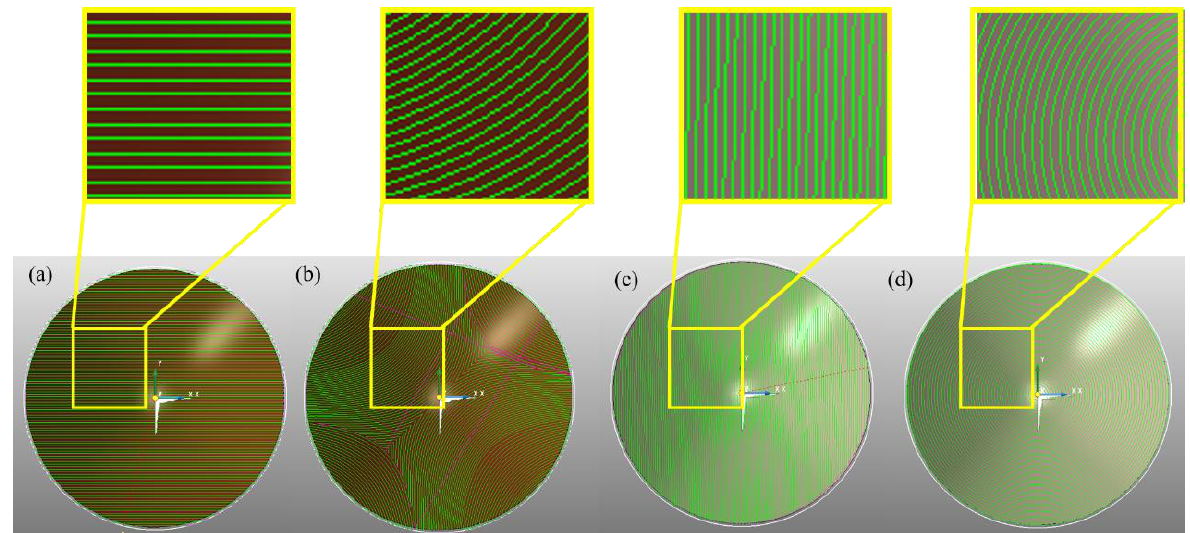
Figure 3. Tool path for convex saddle machining: ( a ) parallel, ( b ) contour, ( c ) surface, ( d ) helical.